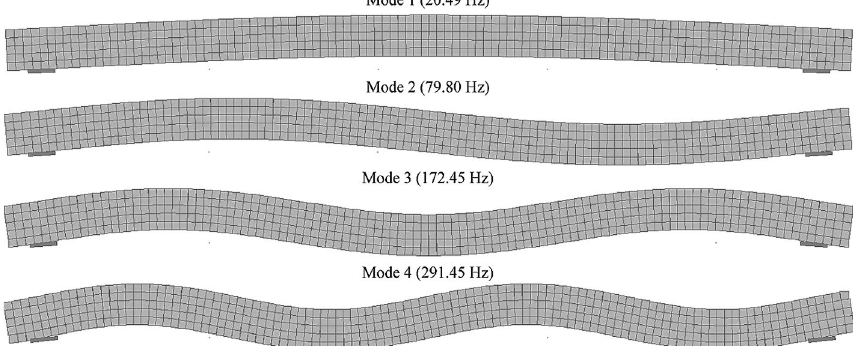
Fig. 11. Natural frequencies and vibration shape mode results of the analysis no. 5 (FCEM), for the first four beam vibration modes Table 3. Natural frequency values (Hz) obtained with different methods for the studied steel frame structure problem, and the corresponding error percentage to the obtained experimental value Vibration Experimental Analysis no. 6 Analysis no. mode number obtained value (FEM)